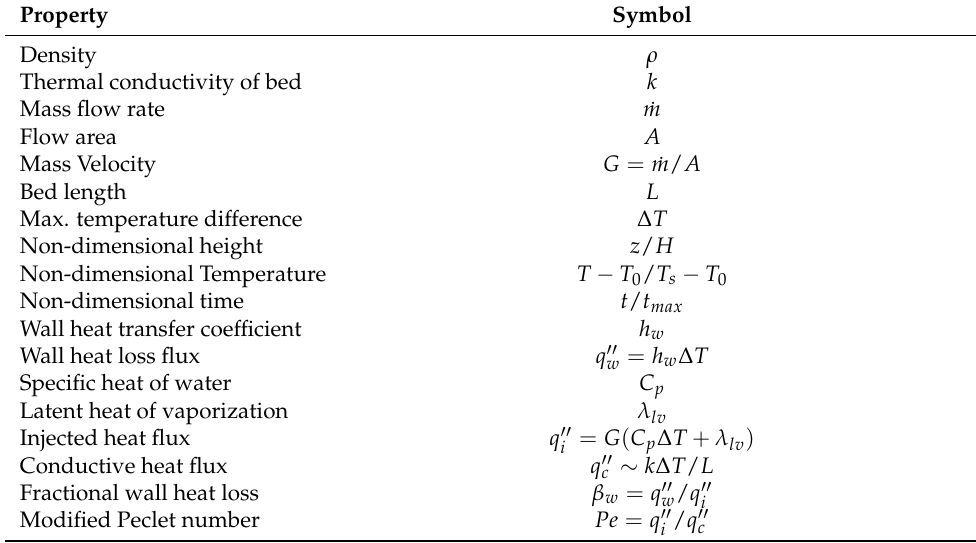
Table 1. Definition of